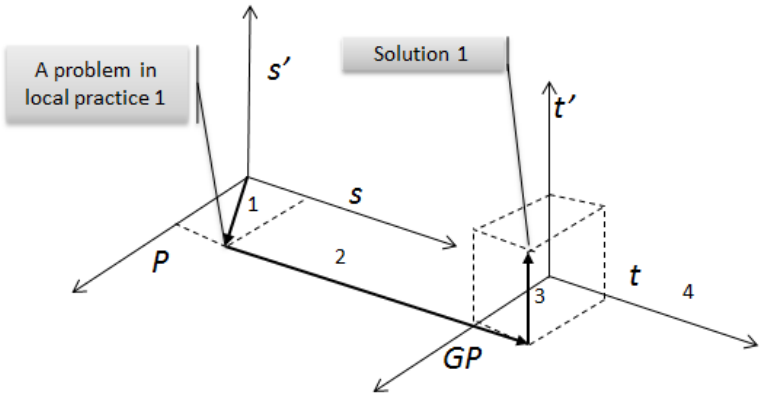
Figure 5. Project 1 – from specific problem to generic